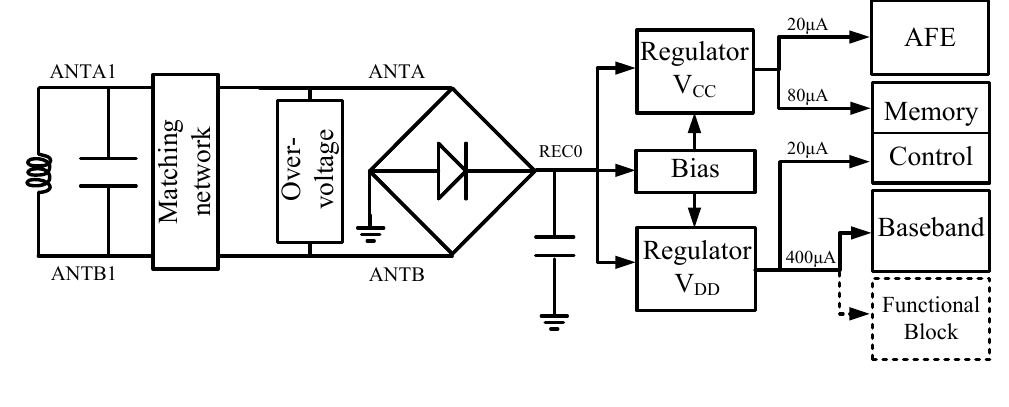
Figure 1. Structure of the RF powering circuit.